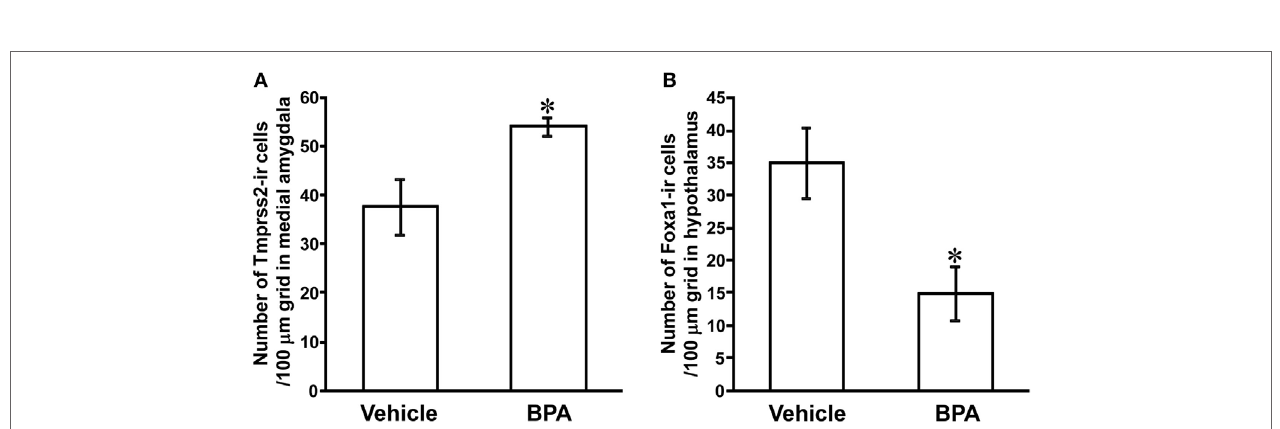
FigUre 4 | Effect of Bisphenol A (BPA) administration on the number of Tmprss2-ir cells in the medial amygdala and Foxa1-ir cells in the hypothalamus of neonatal male rat. (a) Effect of BPA administration on the number of Tmprss2-ir cells in 100 µm grid in the medial amygdala. Each column and the vertical line represent the mean ± SEM. * P < 0.05, vehicle ( n = 4) vs. BPA ( n = 5) by Student’s t -test. (b) Effect of BPA administration on the number of Foxa1-ir cells in 100 µm grid in the hypothalamus. Each column and the vertical line represent the mean ± SEM. * P < 0.05, vehicle ( n = 4) vs. BPA ( n = 4) by Student’s t -test.